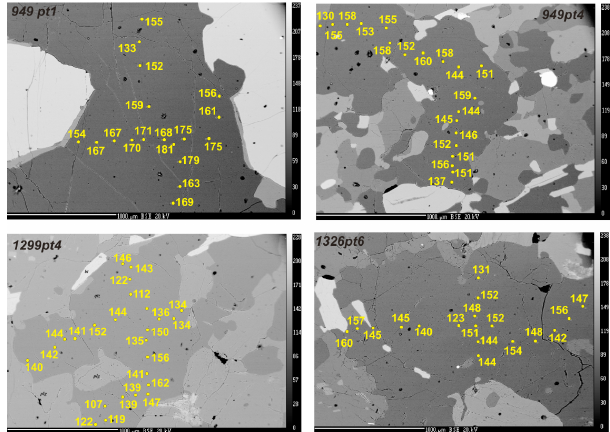
Figure 7. Spots along transverse profiles and respective titanium concentrations (ppm) in quartz from migmatitic kinzigite (samples Ar949 and Ar1326) and from diatexite